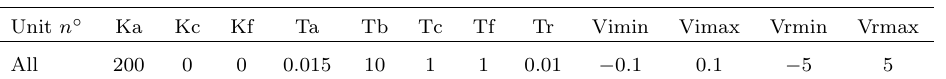
Table A.4. EXST1 model.